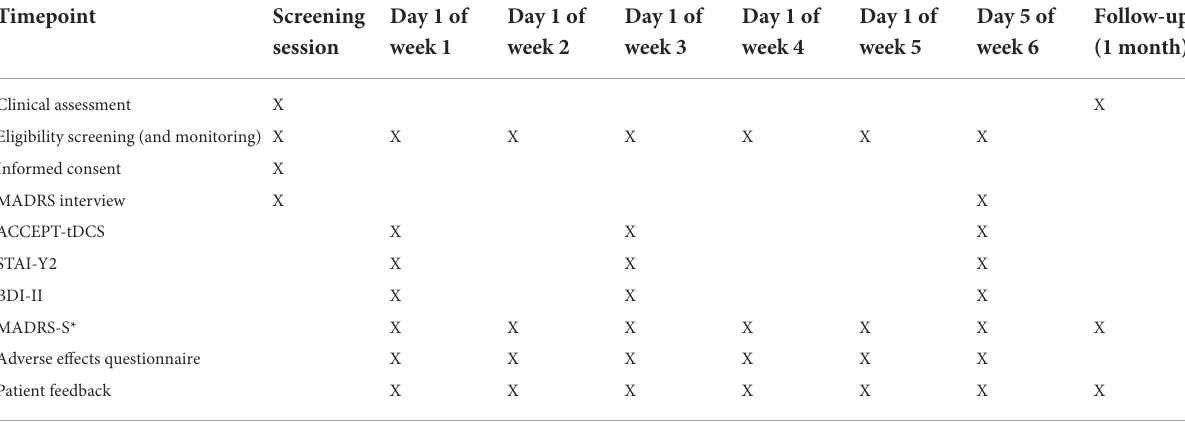
TABLE 1 Flow program treatment